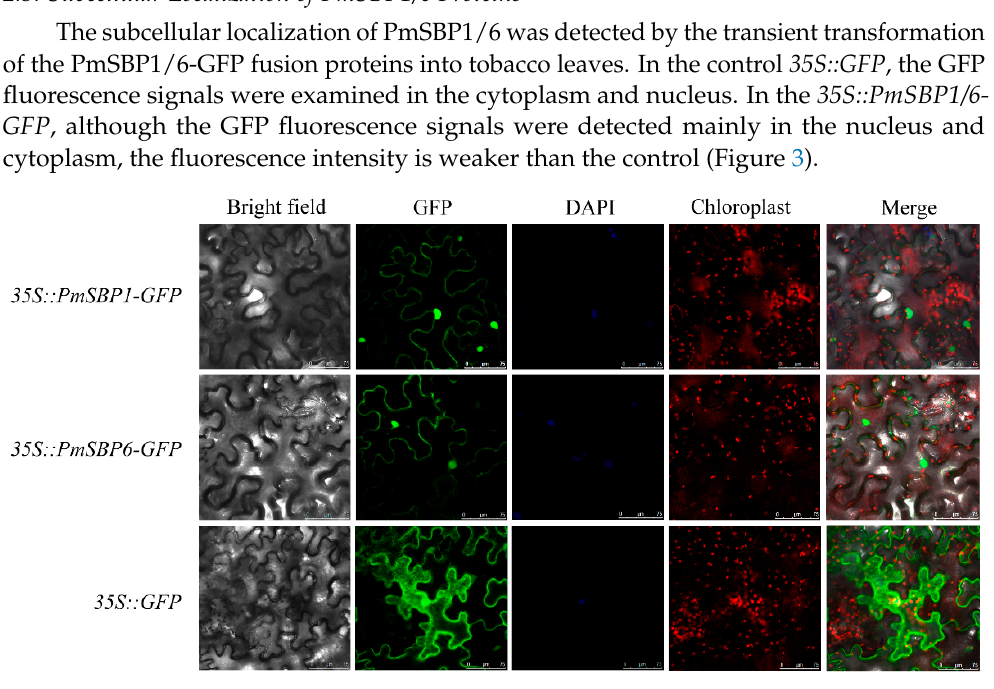
Figure 3. Subcellular localization of PmSBP1/6. The green, blue, and red fluorescence represent GFP fusion protein, nucleus, and chloroplast positions. The merge pictures were made of bright field, GFP, DAPI, and chloroplast pictures. The scale bar = 75 μ m.